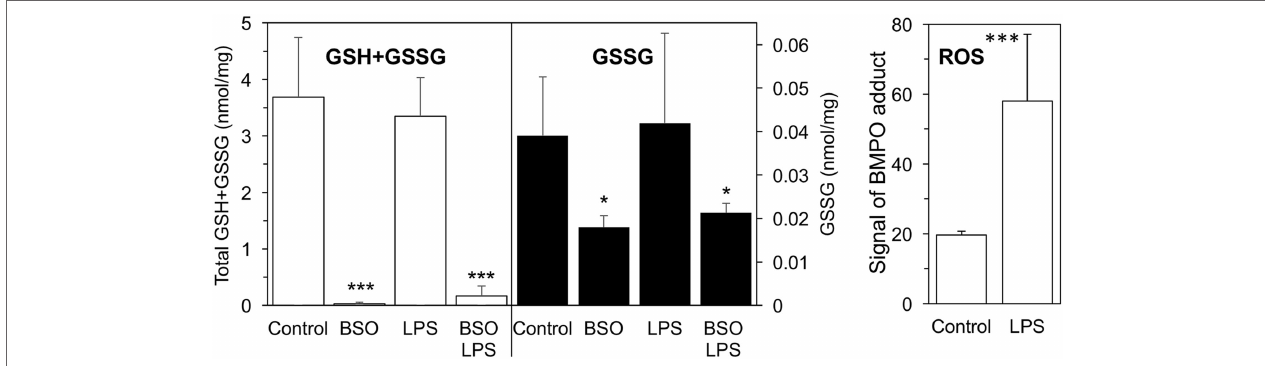
FigUre 1 | GSH + GSSG levels and ROS production in LPS-treated cells with or without BSO. Cells were pretreated with 120 µM BSO for 24 h, followed by 10 ng/ml LPS for 2 h. Total GSH + GSSG and GSSG levels measured in the cell lysates are the mean ± SD of six biological replicates from three independent experiments and are expressed as nmoles/mg protein. ROS production is expressed as signal of BMPO adduct, mean ± SD of six biological replicates from six independent experiments * P < 0.05 and *** P < 0.001 vs control by two-tailed Student’s t -test. BMPO, 5-tert-butoxycarbonyl-5-methyl-1-pyrroline N-oxide; BSO, buthionine sulfoximine; GSH, glutathione; GSSG, glutathione disulfide; LPS, lipopolysaccharide; ROS, reactive oxygen